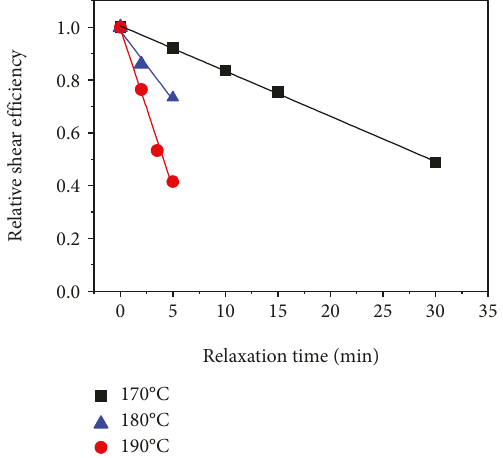
Figure 5: Relative shear e ffi ciency as a function of time at di ff erent relaxation temperatures for β -nucleated iPP. Flow condition: shear rate = 40s − 1 , shear time = 10 s , and T